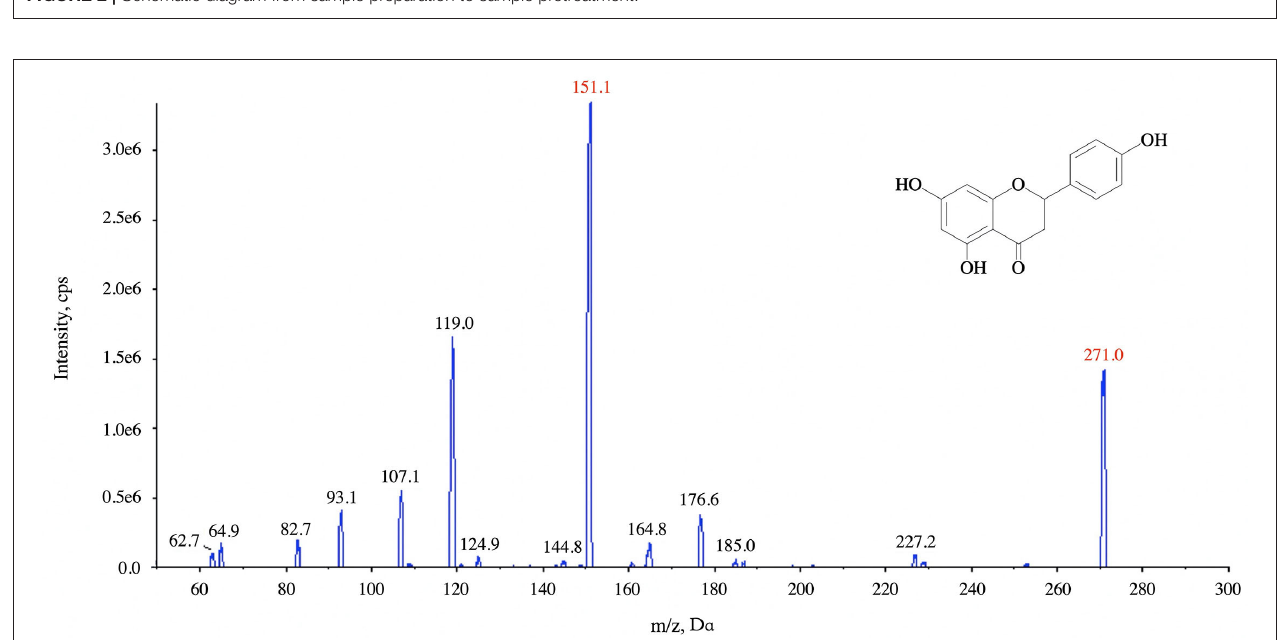
FIGURE 2 | Schematic diagram from sample preparation to sample pretreatment.